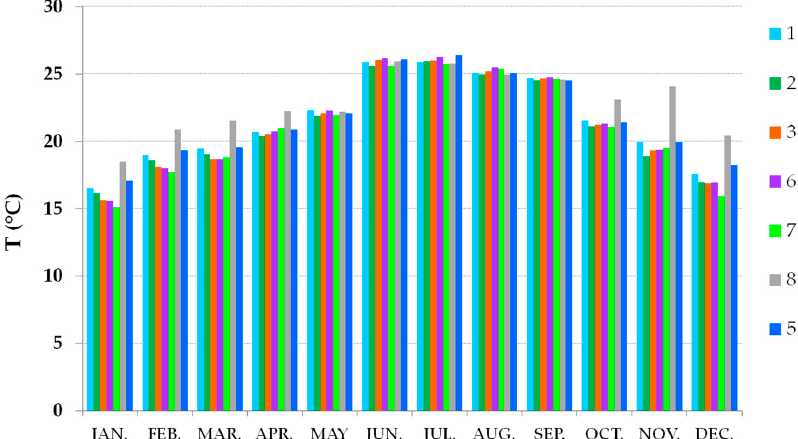
Figure 6. Monthly average temperature values recorded at the monitoring points.